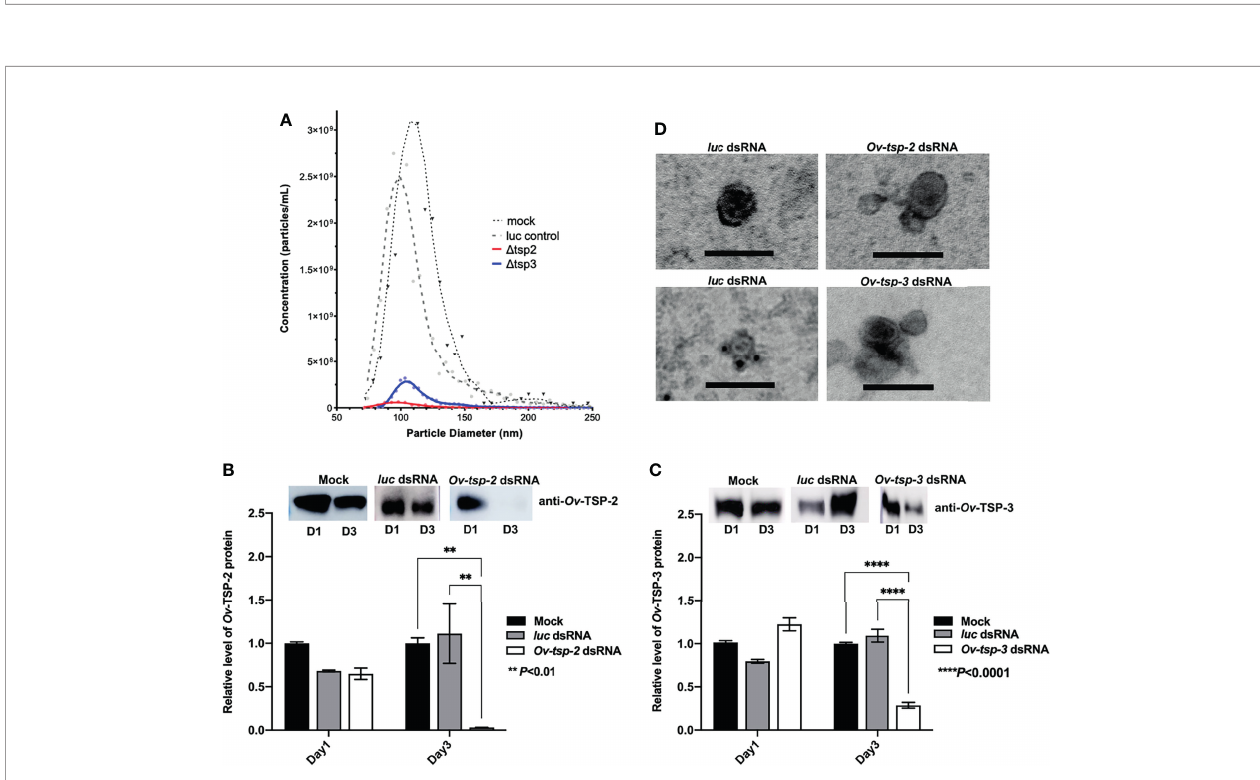
FIGURE 5 | RNA interference-mediated silencing of Ov-tsp-2 and Ov - tsp-3 substantially reduced 120k extracellular vesicle secretion by adult Opisthorchis viverrini in culture. O. viverrini 120k extracellular vesicles (EVs) were puri fi ed from excretory/secretory products of fl ukes treated for one (D1) or three (D3) days with Ov-tsp-2 , Ov - tsp-3 or fi re fl y luciferase dsRNAs in vitro . EVs collected on D3 were quanti fi ed by tunable resistive pulse sensing using a qNano instrument (A) . EVs from dsRNA-treated worms were probed with antisera to Ov -TSP-2 (B) and Ov -TSP-3 (C) by western blot and band intensity was determined using ImageJ software. Con fi rmation of the absence of Ov -TSP-2 and TSP-3 in EVs from dsRNA-treated fl ukes was performed using immunogold transmission electron microscopy (D) . Black dots (antibody binding) are visible on EVs from luc dsRNA-treated fl ukes but not EVs from Ov-tsp-2 or Ov-tsp-3 dsRNA-treated fl ukes when probed with homologous antisera. The black scale bar denotes 100